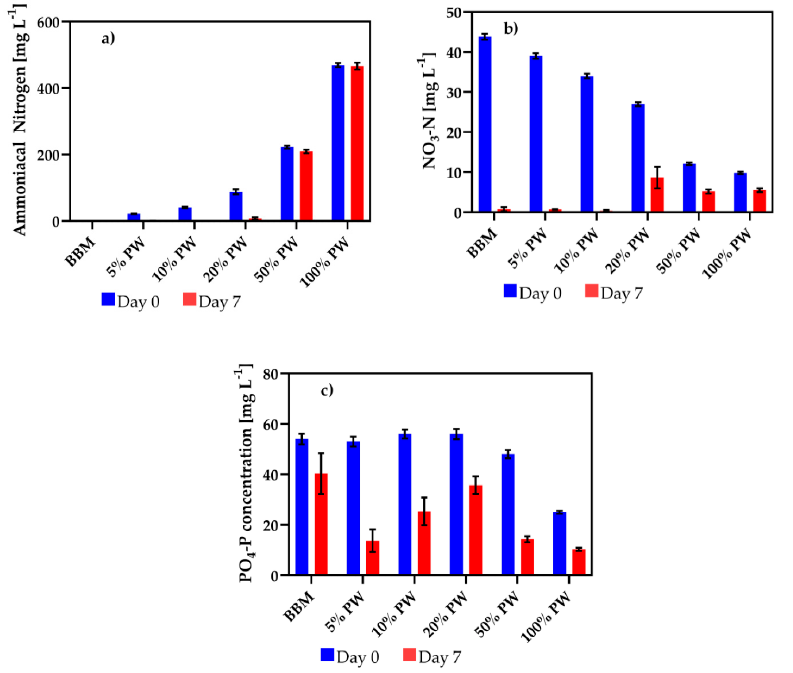
Figure 3. ( a ) NH 4 –N removal, ( b ) NO 3 –N removal and ( c ) PO 4 –P removal; by C. vulgaris in BBM and different PW dilution experiments over 7 days Data points represent the average ± SD of n = 3 biological